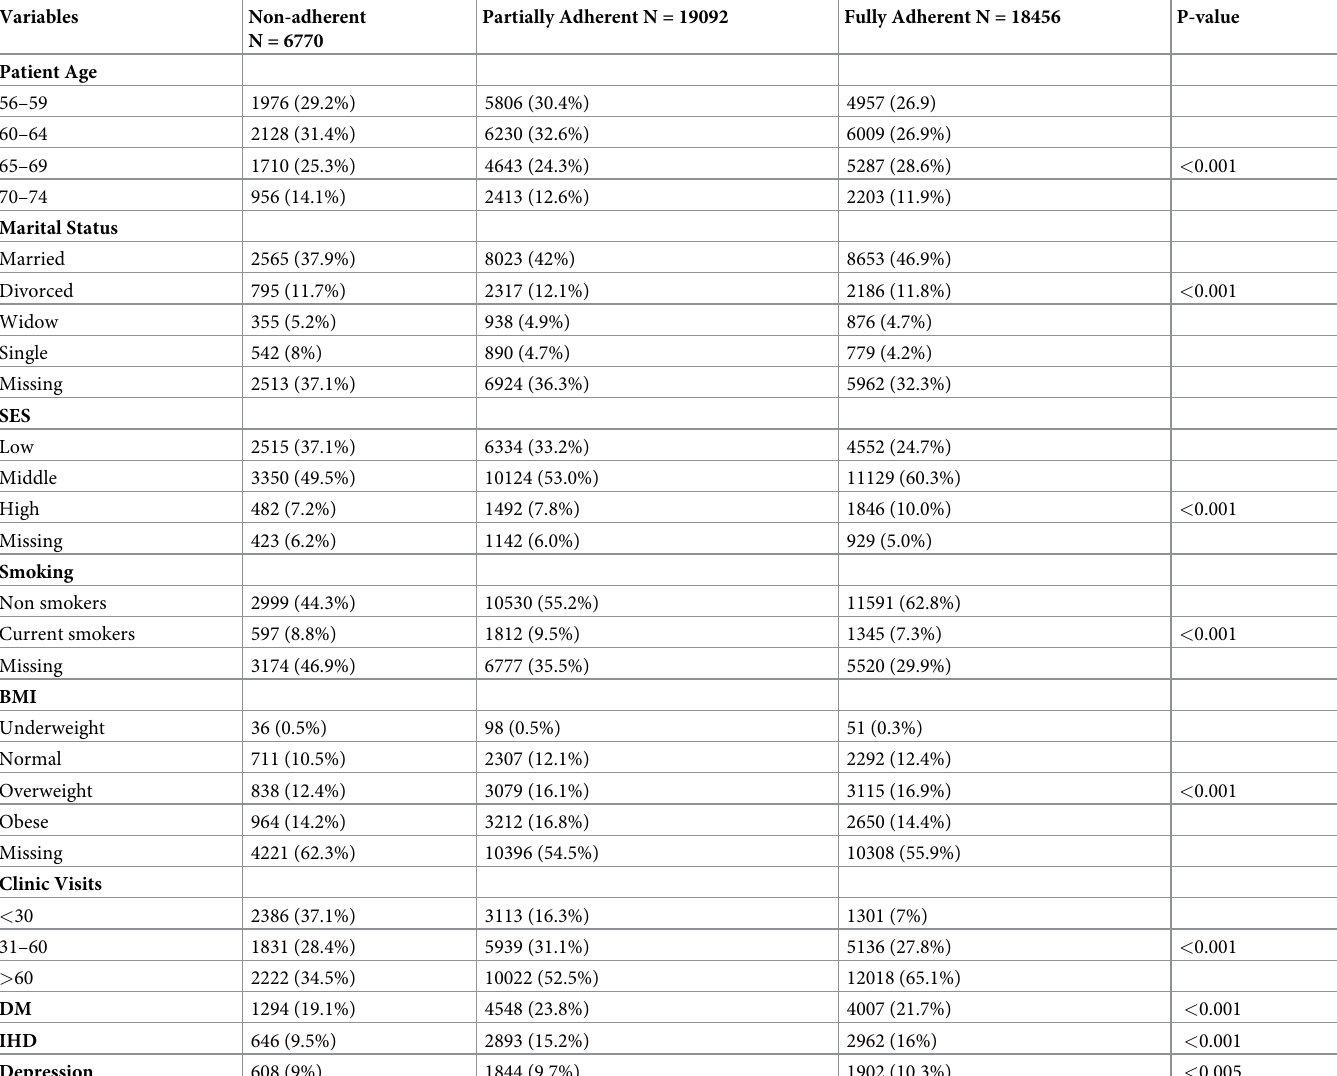
Table 1. Distribution of individual characteristics of the study population by adherence to